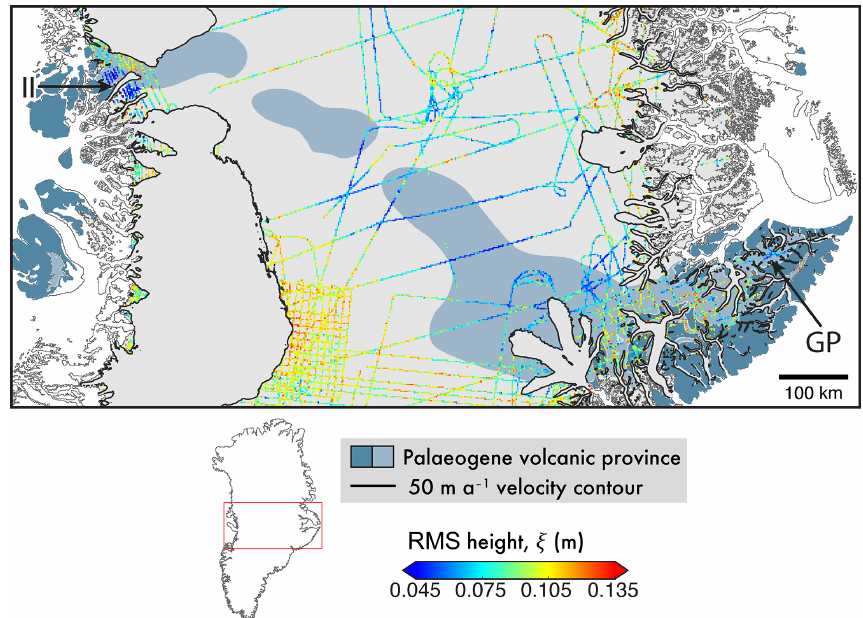
Figure 13. Geological interpretation using ξ in central Greenland. Values of ξ in fast-flowing regions are masked (delineated by black contour; | v | > 50ma − 1 ). Exposed or ice-free (dark shading) and predicted extent (light shading) of a Palaeogene volcanic province (Dawes, 2009) is underlain. This feature is bounded west and east by Ìngia Isbræ (II) and Geikie Plateau (GP), respectively. Location